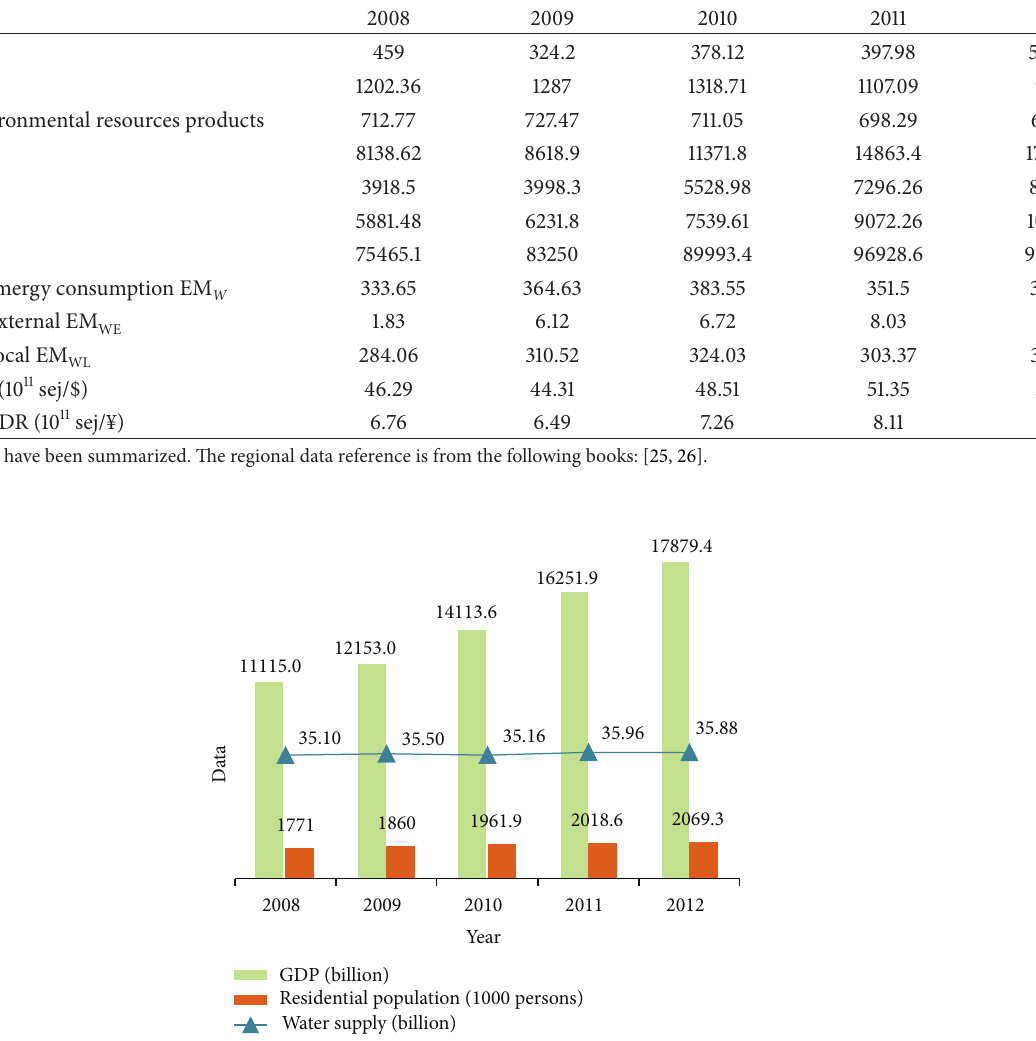
Figure 2: The population of permanent residents, water supply, and gross domestic product (GDP) of Beijing. Source :